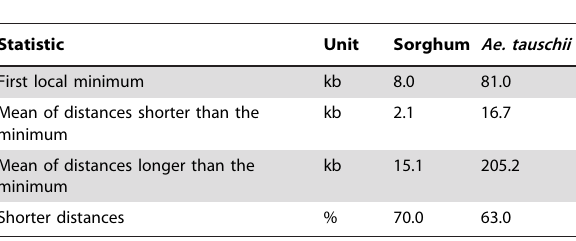
Table 2. Insular structure in sorghum and Ae.